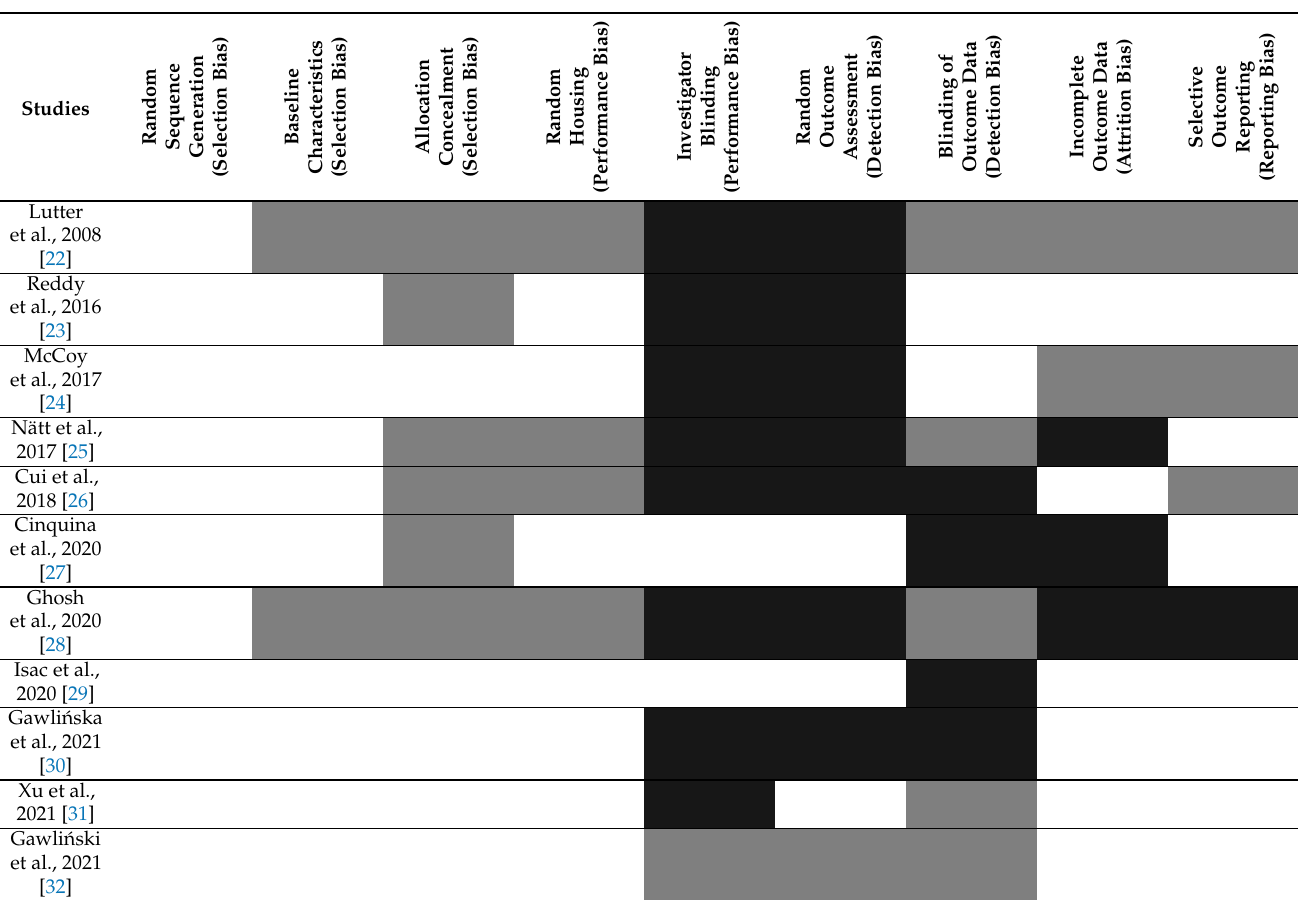
Table 2. Risk of bias